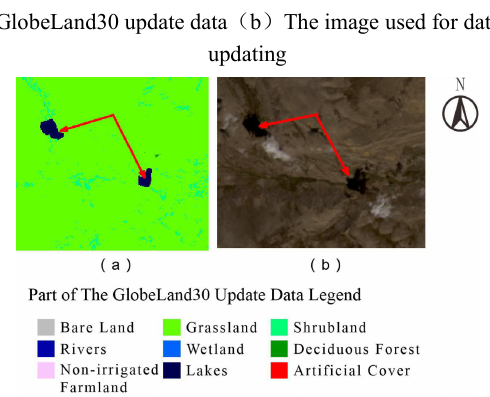
Figure 4. Cloud shadows are misclassified as lakes （ a ） GlobeLand30 update data （ b ） The image used for data